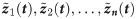
The block diagram of robust FOPID control in CPS framework with real-time setpoints and noise in model’s feedback.Real-time setpoint is estimated by approximation function of environmental factors (z~1(t),z~2(t),…,z~n(t)). Anomaly in sensor’s feedback is function of uncertain variable α~. FOPID gain parameters and order parameters are tuned robustly in such a way to make CPS insensitive against sources of variability in system.